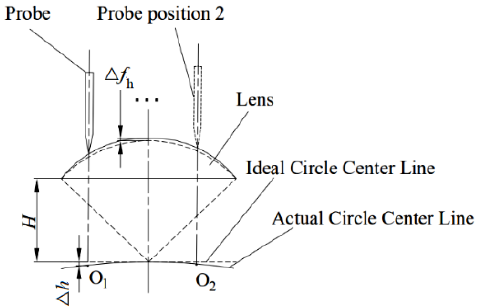
Figure 6. Geometric relationship between spherical out-of-roundness and measurement error.